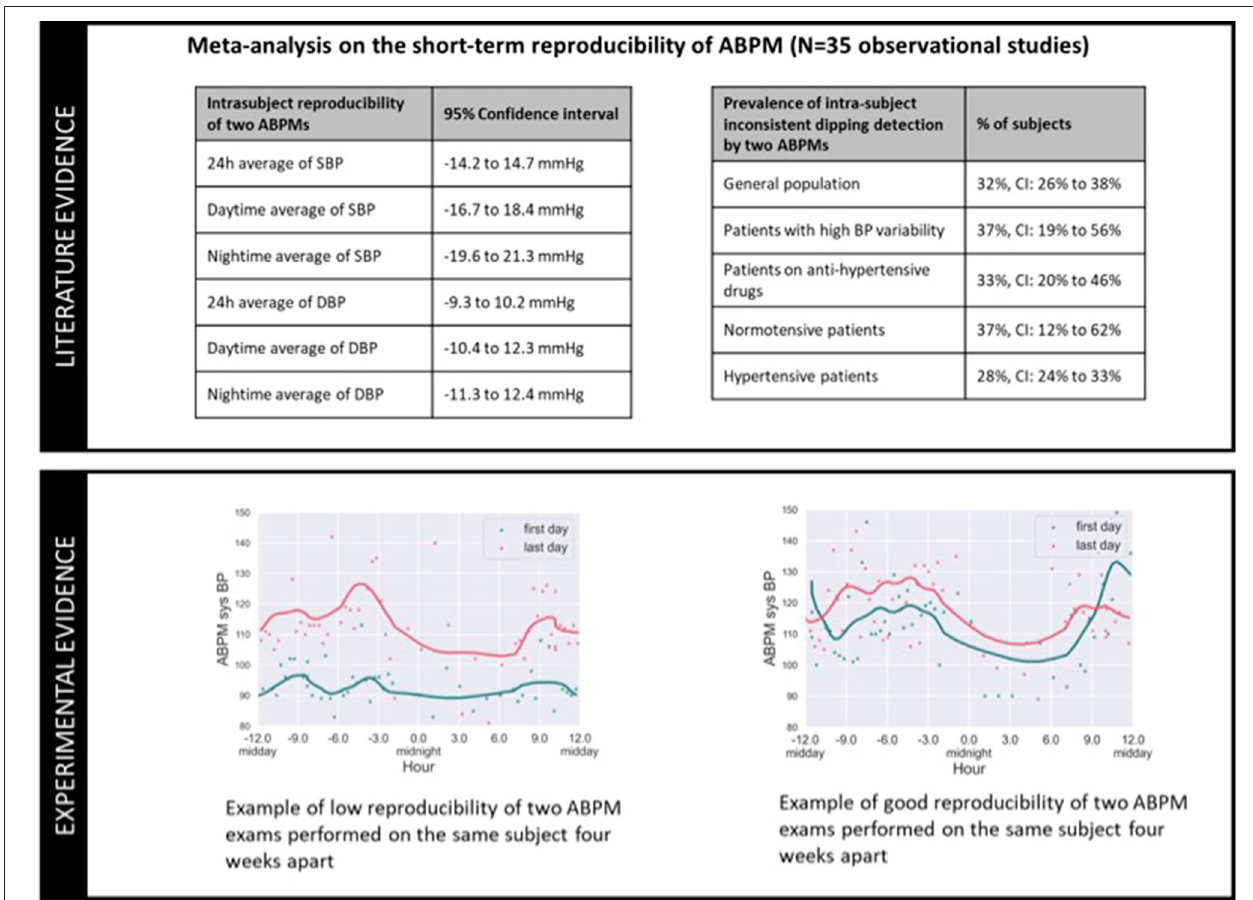
FIGURE 6 | Illustration of the poor intra-subject reproducibility of ABPM exams: because the circadian BP excursions of an individual varies over time, by choosing arbitrary day(s) of measurement, an ABPM exam might generate a phenotype that misrepresents the underlying BP phenotype of the patient.